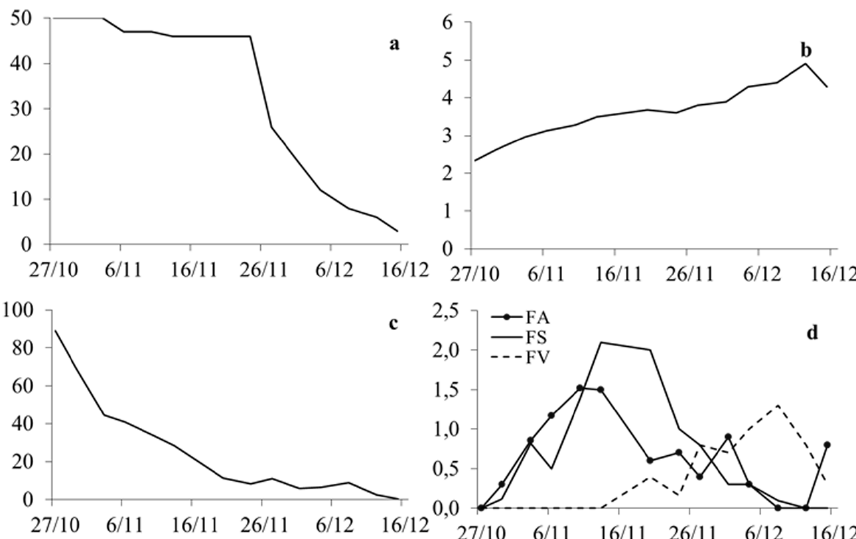
Figure 3 - Monitoring the development of inflorescence of Varronia curassavica Jacq. a) Number of monitored inflorescences; b) Length of inflorescence (cm); c) average number of flower buds; d) average number of open flowers (FA), average number of senescent flowers (FS); average number of immature fruits